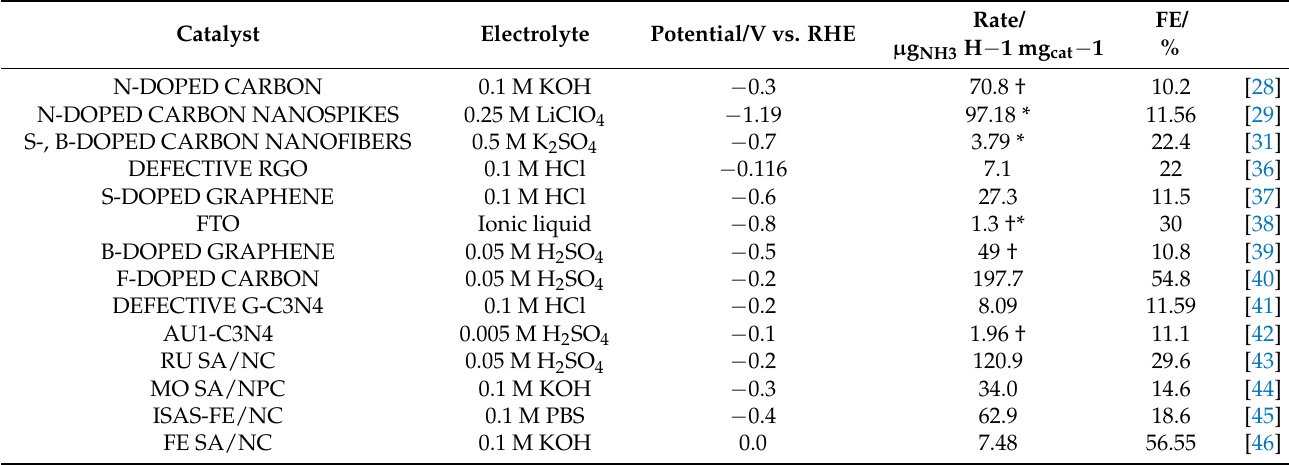
Table 1. Carbon-based catalysts for NRR investigated in this review and their main catalytic parameters (ammonia formation rate and Faradaic Efficiency